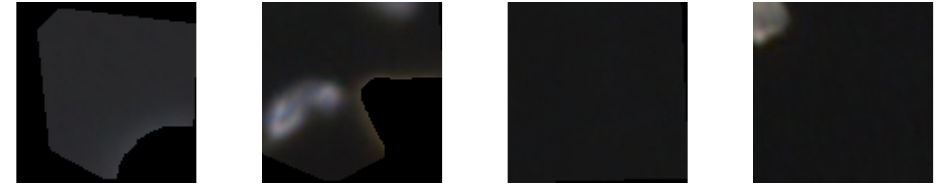
Figure 8. Sample images of background class.